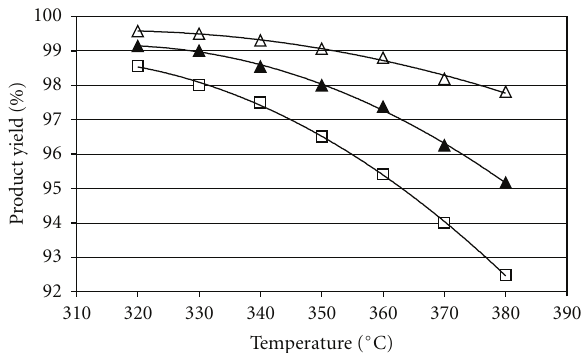
-1.0 h − 1 , -2.0h − 1 and -3.0h − 1 (cid:3) (cid:0) (cid:2)